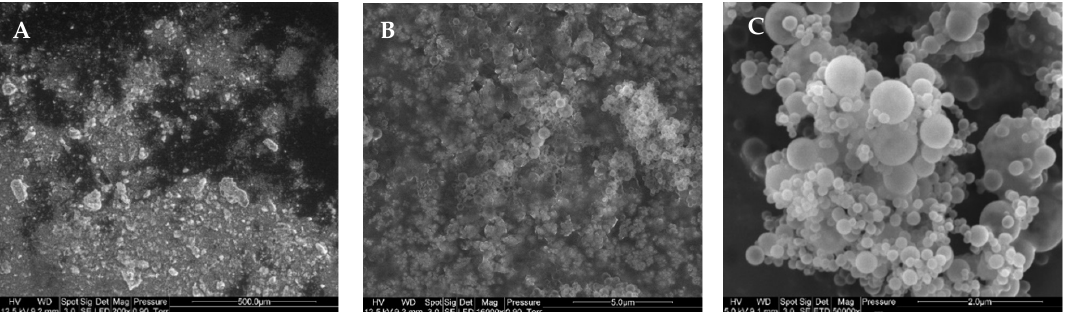
Figure 5. Scanning electron microscopy pictures of mini ‐ emulsion synthesized MIPs zoomed in 200 times ( A ), 1600 times ( B ), and 50,000 times ( C ).